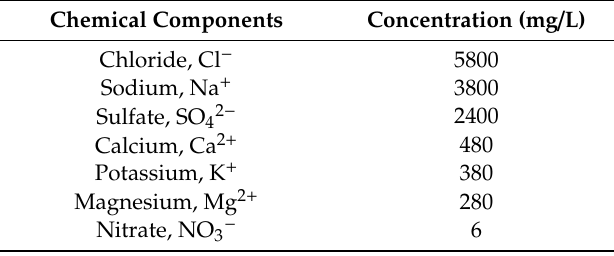
Table 3. Chemical composition of the processed mine